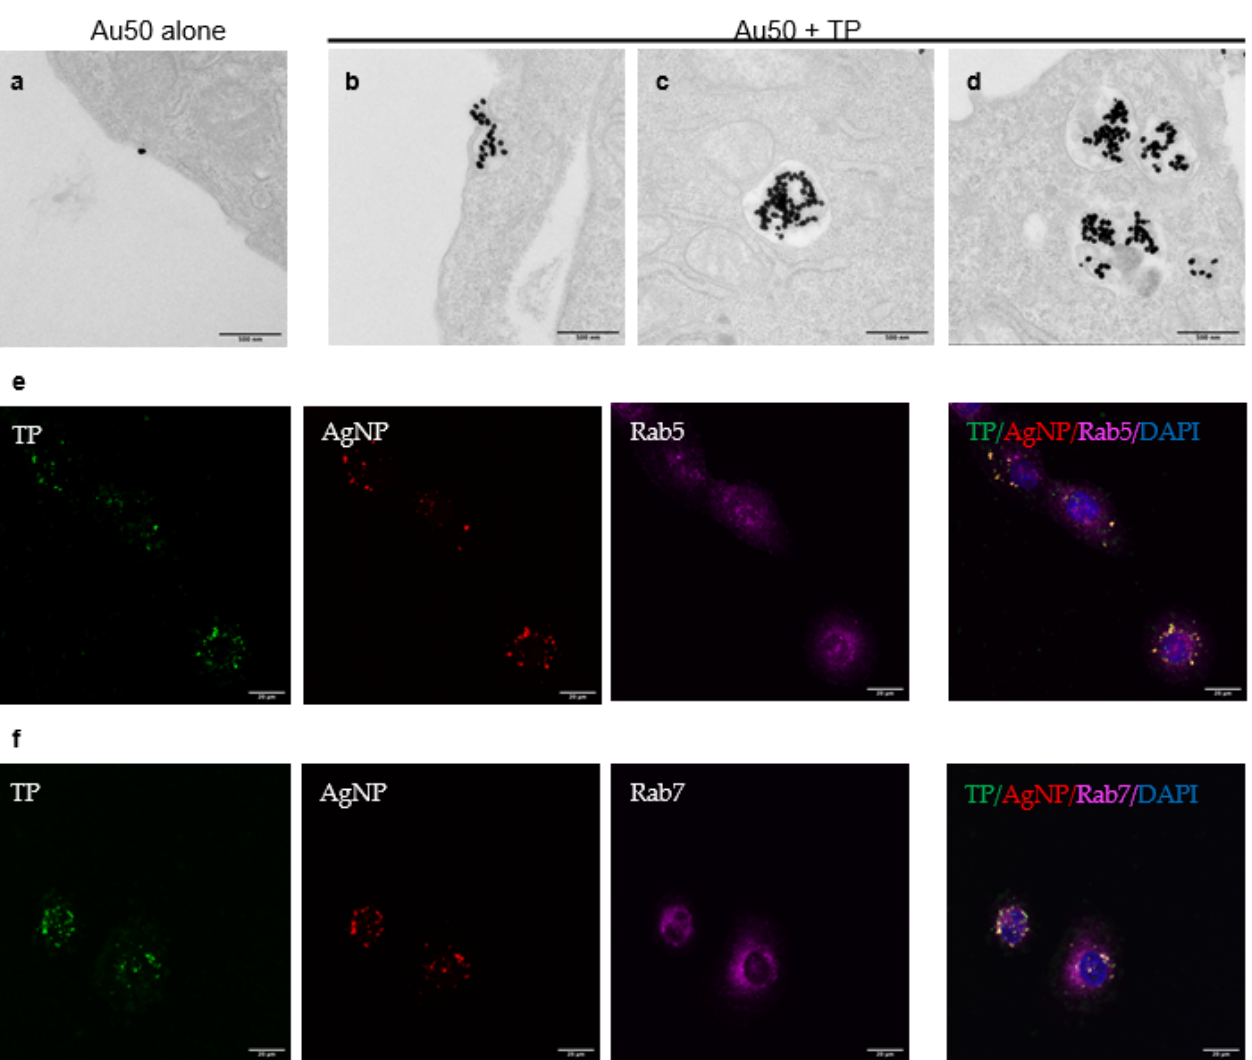
Figure 4. Imaging of endocytic structures for bystander uptake. CHO cells were incubated with Au50 alone ( a ) or Au50 + TP ( b – d ) in the serum-free DMEM medium for 2 h before fixation and being processed for TEM imaging. Ultrastructurally, AuNPs were found in macropinosome-like endocytic vacuoles (>200 nm in diameter) ( b ), early endosomes ( c ) and late endosomal multivesicular bodies ( d ). Presentative images were shown here. Scale bars, 500 nm. ( e , f ) Colocalization of bystander AgNP with endosome markers as revealed by confocal imaging. Hela cells were incubated with FAM-TP (green) and bystander AgNP (AgNP-555, red) for 1 h. Endosome markers (magenta) were stained by immunofluorescence, as described in the Methods. Bystander AgNPs were caputured in Rab5-localized early endosomes ( e ) and Rab7-localized late endosomes ( f ). Scale bars, 20 μ m.